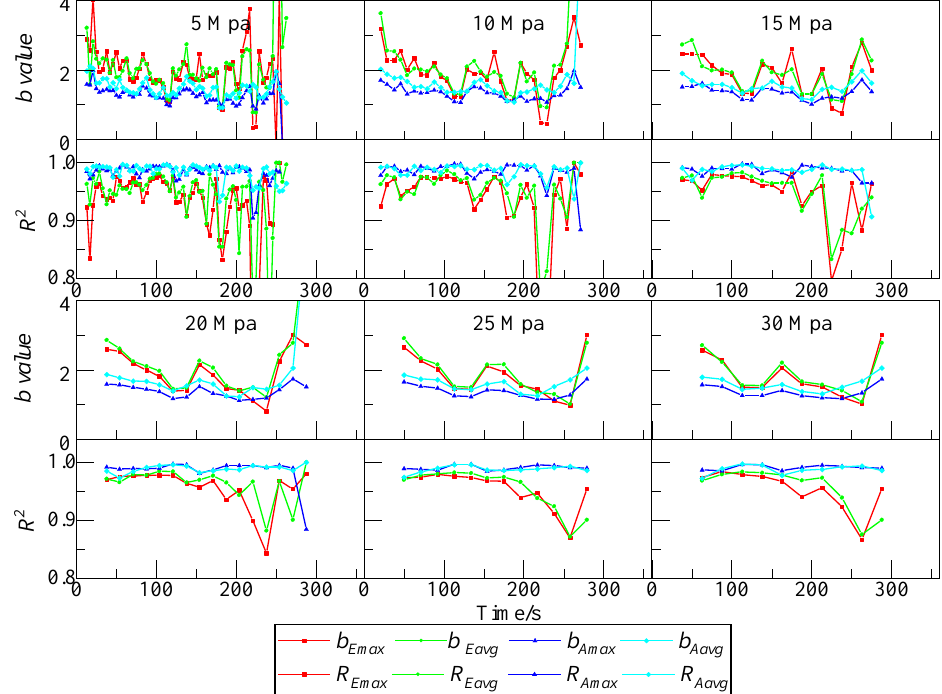
Figure 8. b value and its fitting goodness at different stress proportion intervals for the specimen G-10-10. The range of b Amax values is between 0 to 2.21.